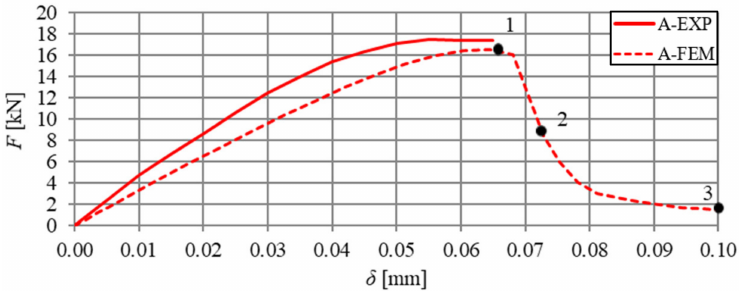
Figure 19. Comparison of numerical and experimental force–deflection relationship of HSC beams in three-point bending tests (series A).